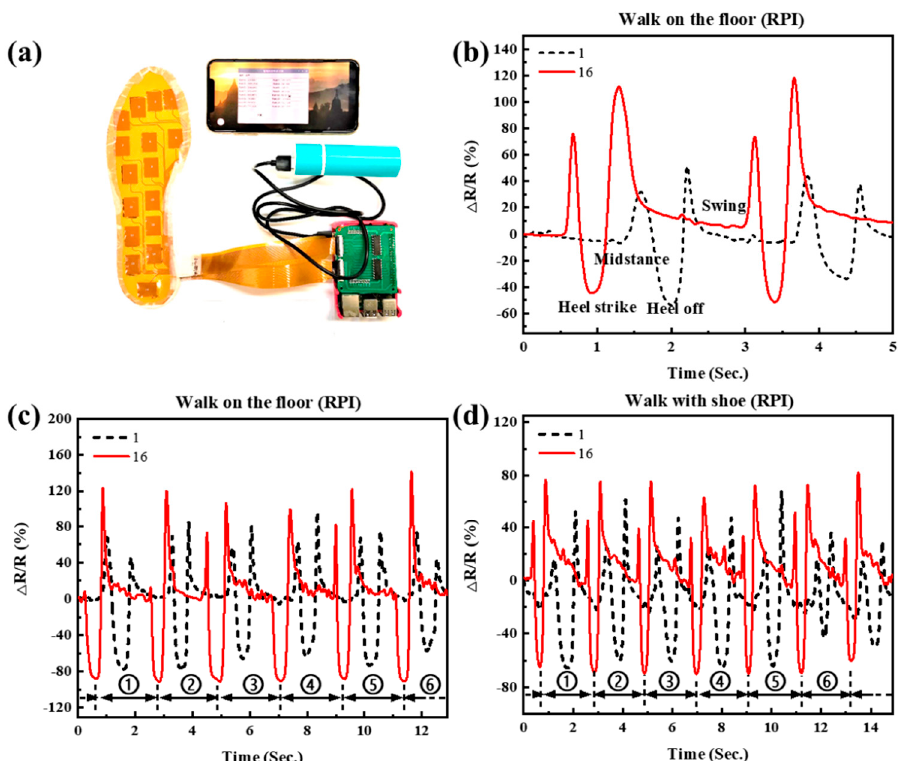
Figure 7. ( a ) Diagram of gait cycle test using RPI system. ( b ) Resistance response of sensor points 1 and 16 when walking on the floor. ( c , d ) Gait cycle test while walking in shoes and walking on the floor, respectively.